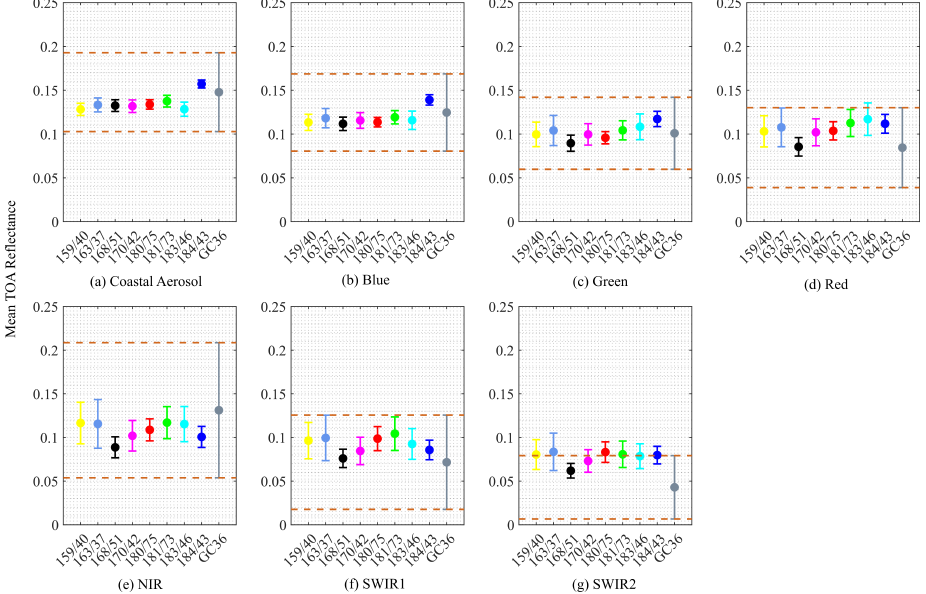
Figure 4. TOA reflectance comparison between selected dark target (L8) and GC-36 and red dotted lines showing the 3 σ TOA reflectance of